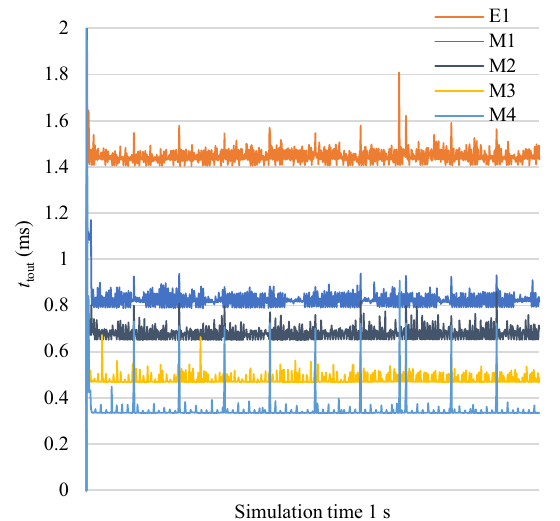
Fig. 17 Total time t tout from the simulation in every stage with a timestep of 1 ms for case